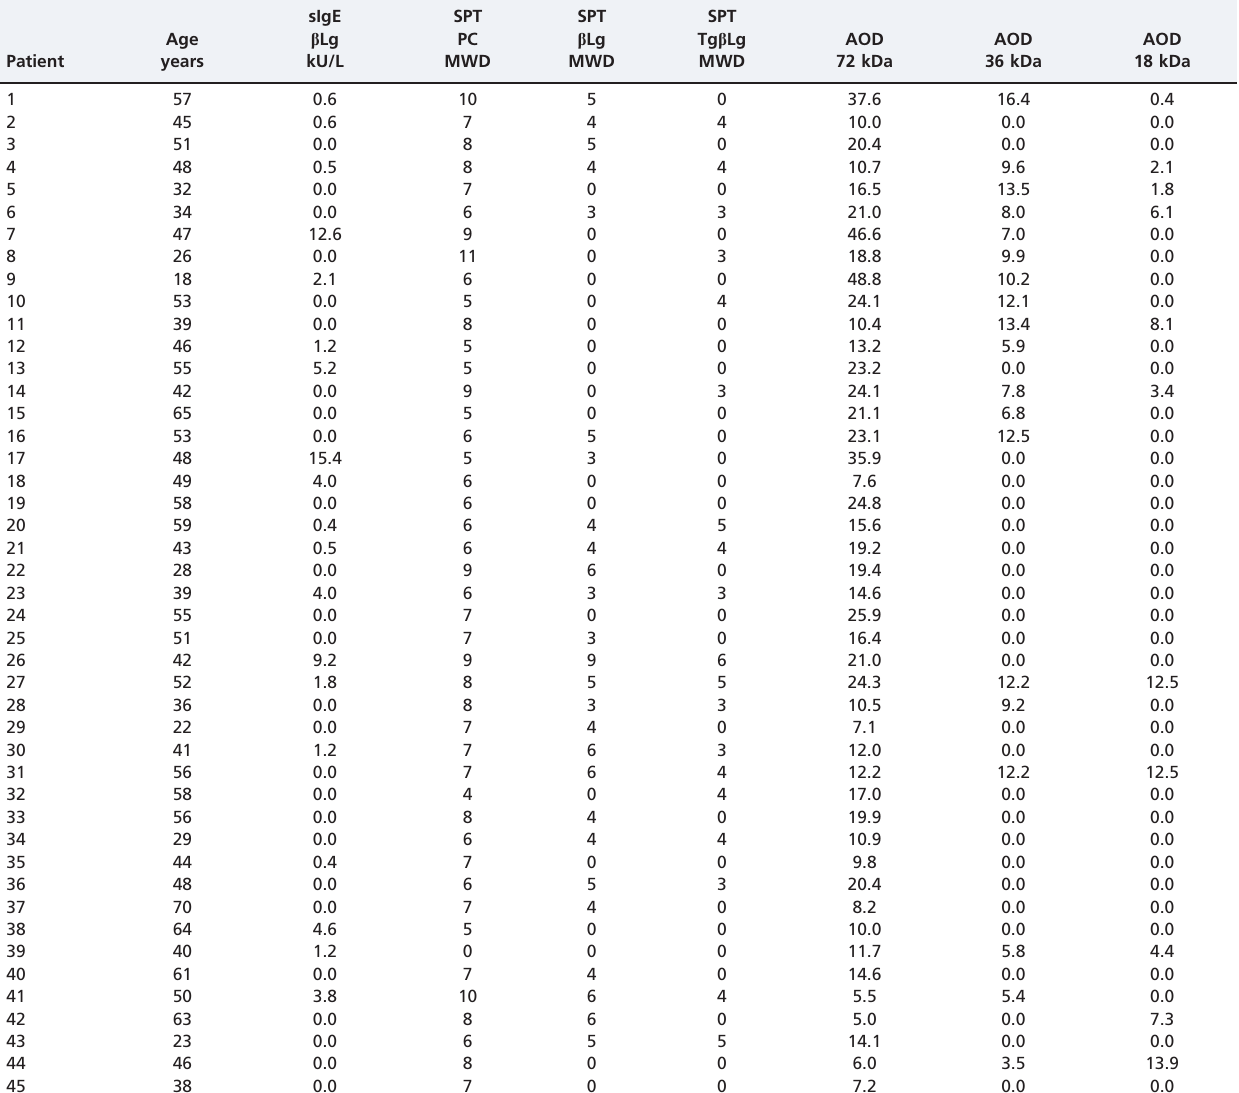
Table 1 - Test results from group A patients.